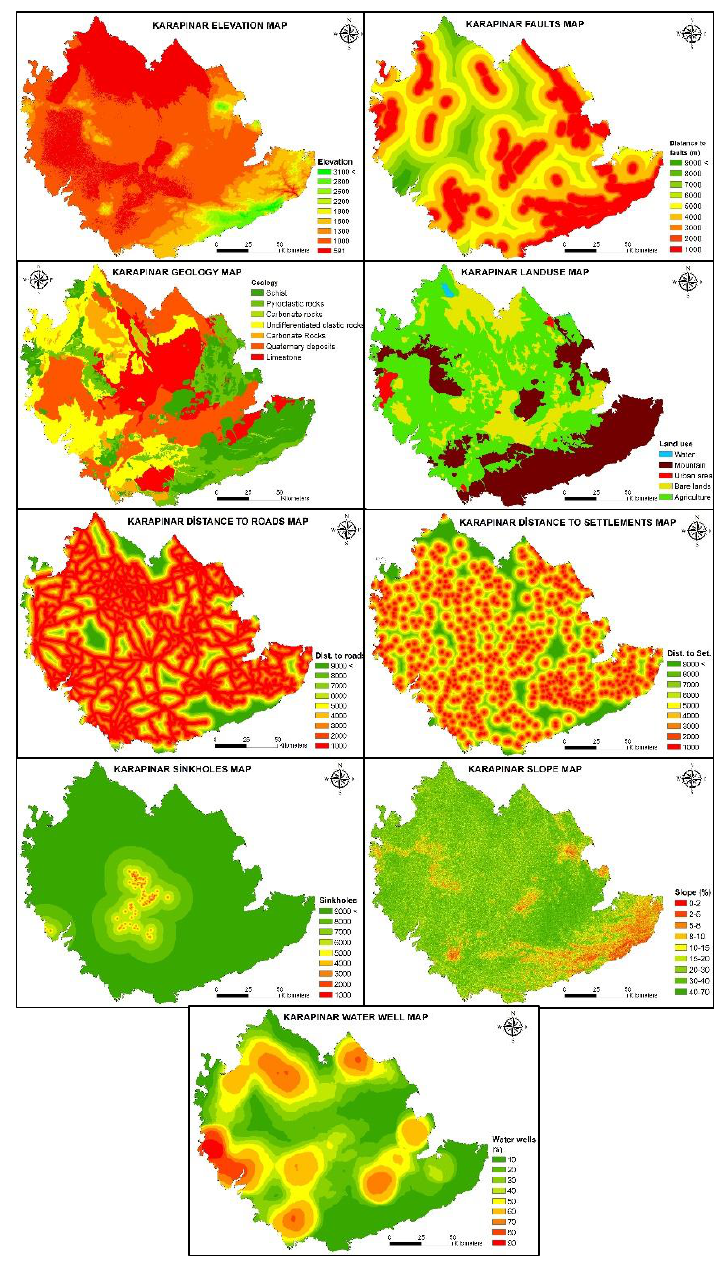
Figure 3. Criteria